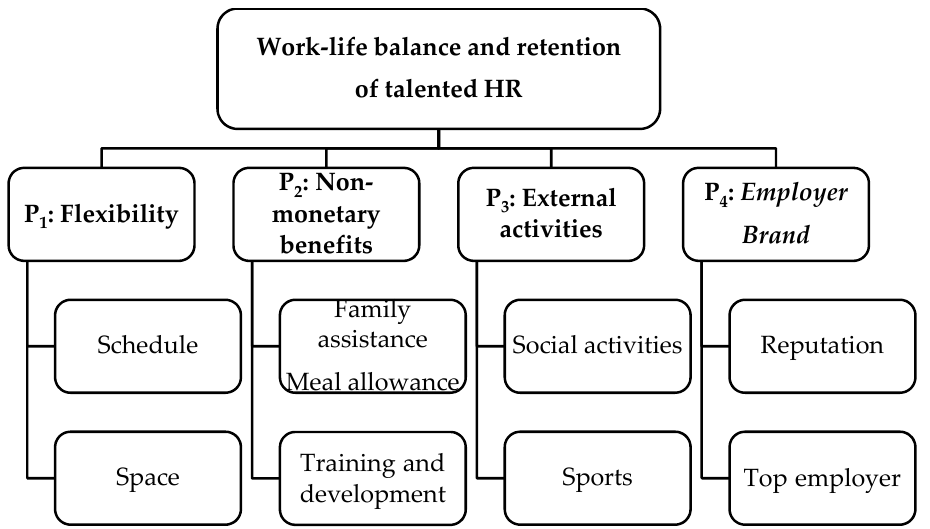
Figure 1. Strategies for work–life balance and retention of valuable HR.